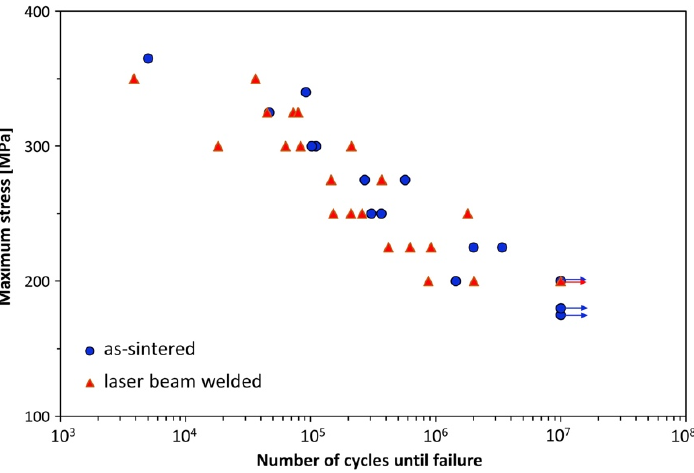
Figure 8. Fatigue test results of LBWed CoCrFeNiMn HEA and BM. Reproduced with permission from [72]. Copyright Elsevier,